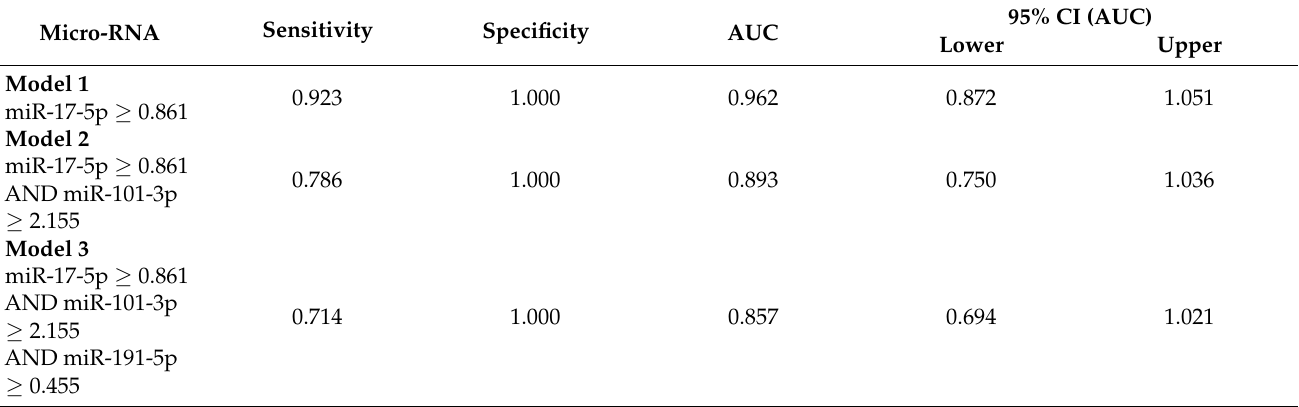
Table 4. Evaluation of microRNAs 17-5p, 101-3p, and 191-5p for death due to tumor progression prediction in patients with metastatic papillary thyroid